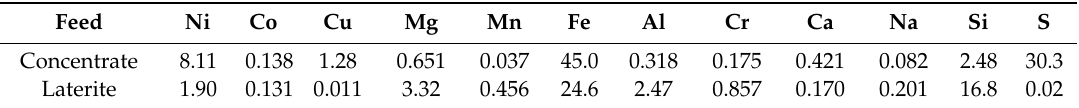
Table 1. Elemental compositions of the low-grade nickel concentrate and high-grade laterite feeds employed in this study (% w /